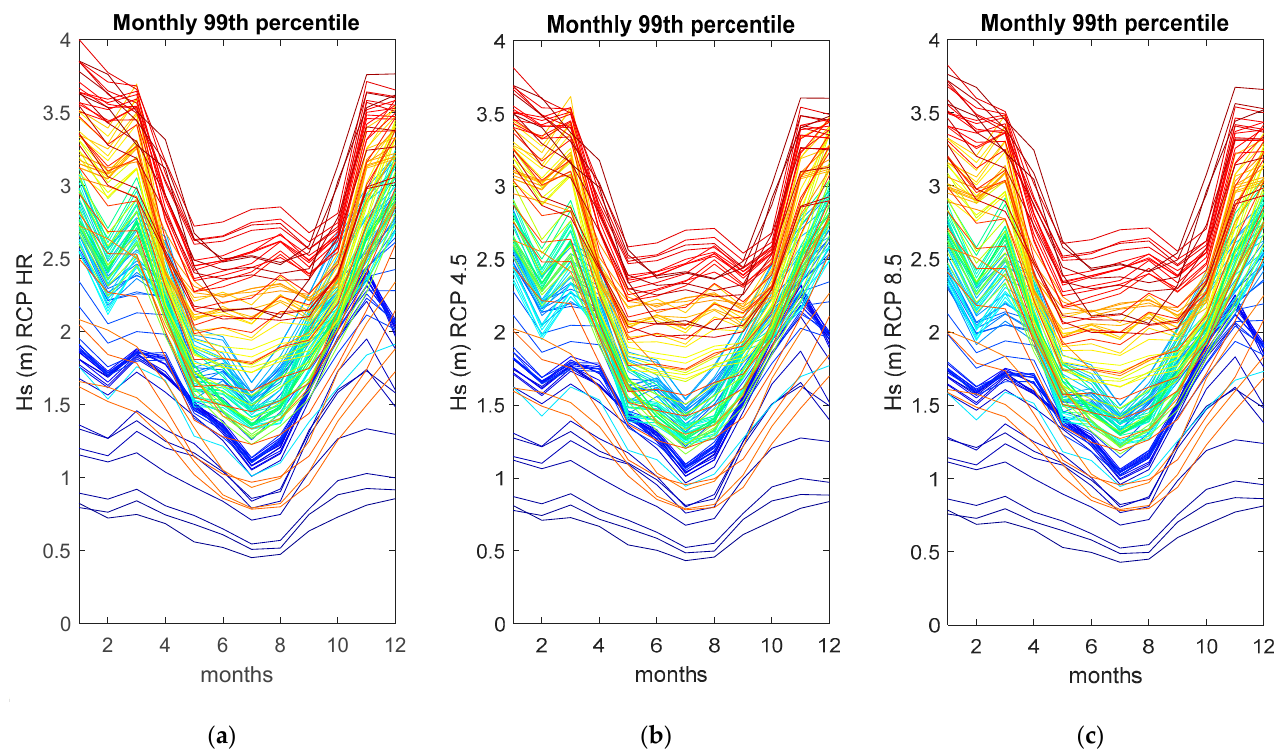
Figure 6. Monthly 99th percentiles of the significant wave heights Hs computed at the 120 virtual buoys along the Italian Adriatic coast (colors are the same used in the previous figures): ( a ) historic run (HR); ( b ) RCP 4.5 scenario; ( c ) RCP 8.5 scenario.